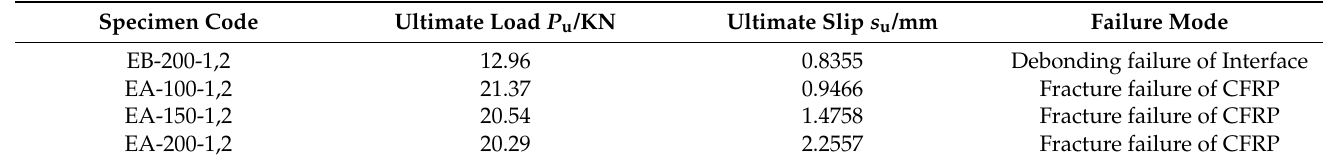
Table 2. Failure modes.